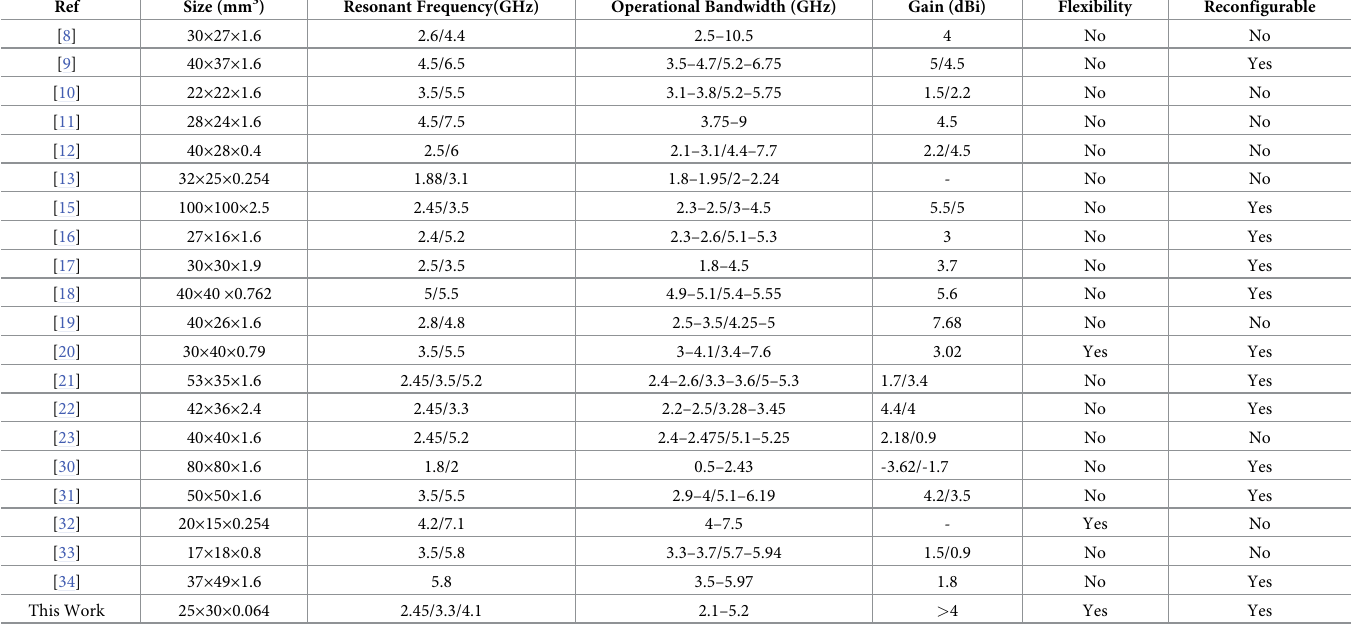
Table 2. Comparison of proposed antenna with other antennas reported in